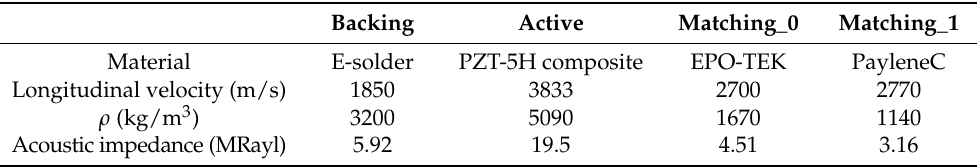
Table 3. Acoustic properties of fabricated 2-2